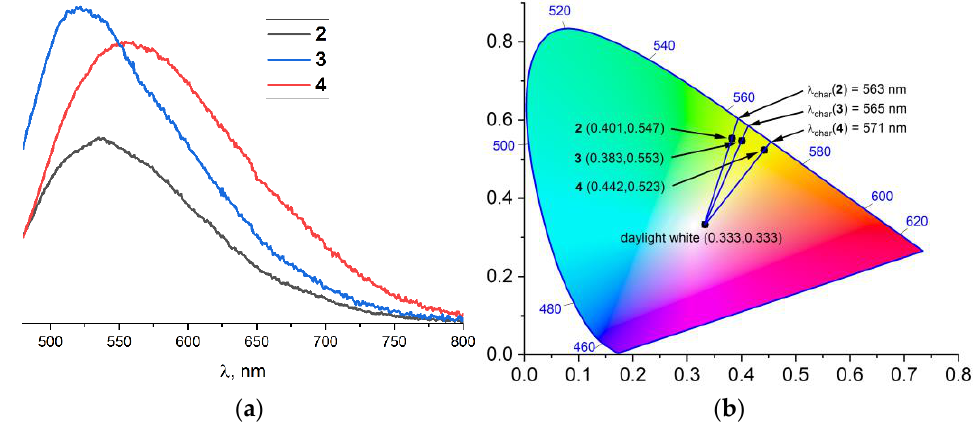
Figure 4. Emission spectra for 2 – 4 at λ ex = 460 nm ( a ), CIE 1931 chromaticity diagram for 2 – 4 ( b ).